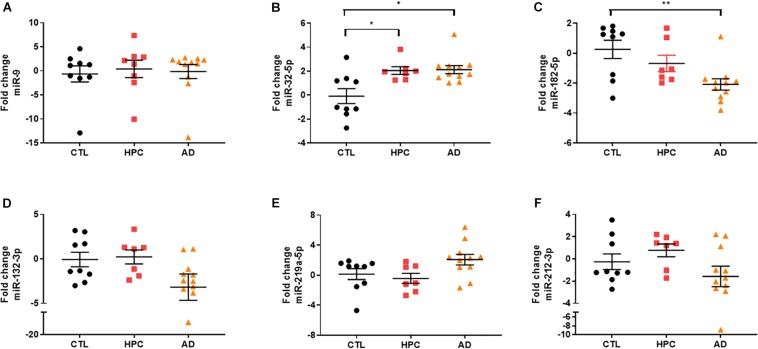
miRNA validation in AD brain tissue by qRT-PCR. miRNA candidates were measured by miRNA-specific qRT PCR. (A) Neuron-specific miR-9 levels, which was similar between disease groups in array analysis, were also unchanged by qRT-PCR [X2(2) = 0.5263, p = 0.769]. Two of the original hits (B) miR-182-5p (∗∗ = 0.009) and (C) miR-32-5p (control vs. HPC, ∗ = 0.049; control vs. HPC, ∗ = 0.025) identified by miRNA arrays were validated by qRT-PCR. (D) miR-132-3p was significantly changed between disease groups [X2(2) = 6.156, p = 0.046], but did not reach statistical significance in pair-wise comparisons. (E) MiR-219a-5p showed a strong trend for change between the three disease groups [X2(2) = 5.906, p = 0.051]. (F) miR-212-3p levels were not significantly changed between disease groups. Fold change was determined by 2–ΔΔCt relative to miR-16. Significance was determined by Kruskal–Wallis test followed by Dunn‘s post hoc test.